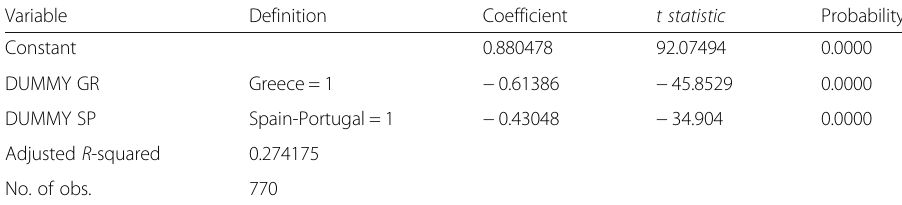
Table 2 TSL vs dummies for Greece and the Spain-Portugal group (SP)